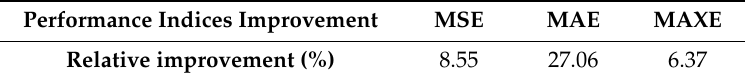
Table 12. Relative performance improvement of the SMO-based estimator over the phasor diagram based estimator during dynamic disturbances of active power for generator operating point P = 0.89, Q = 0.11